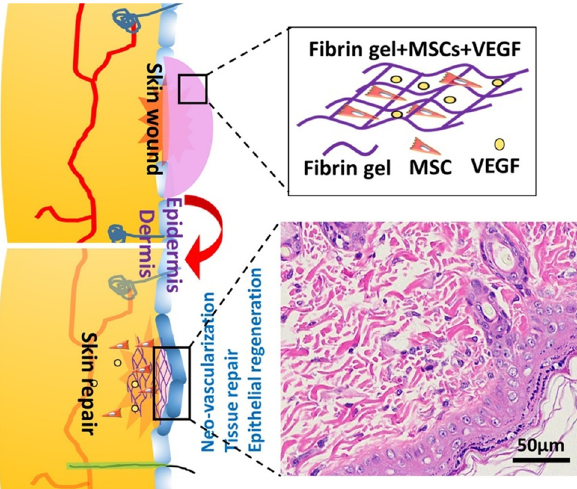
Figure 7: Schematic diagram of biofunctionalized fi brin gel co - embedded with BMSCs and VEGF for accelerating skin injury repair [ 155 ]